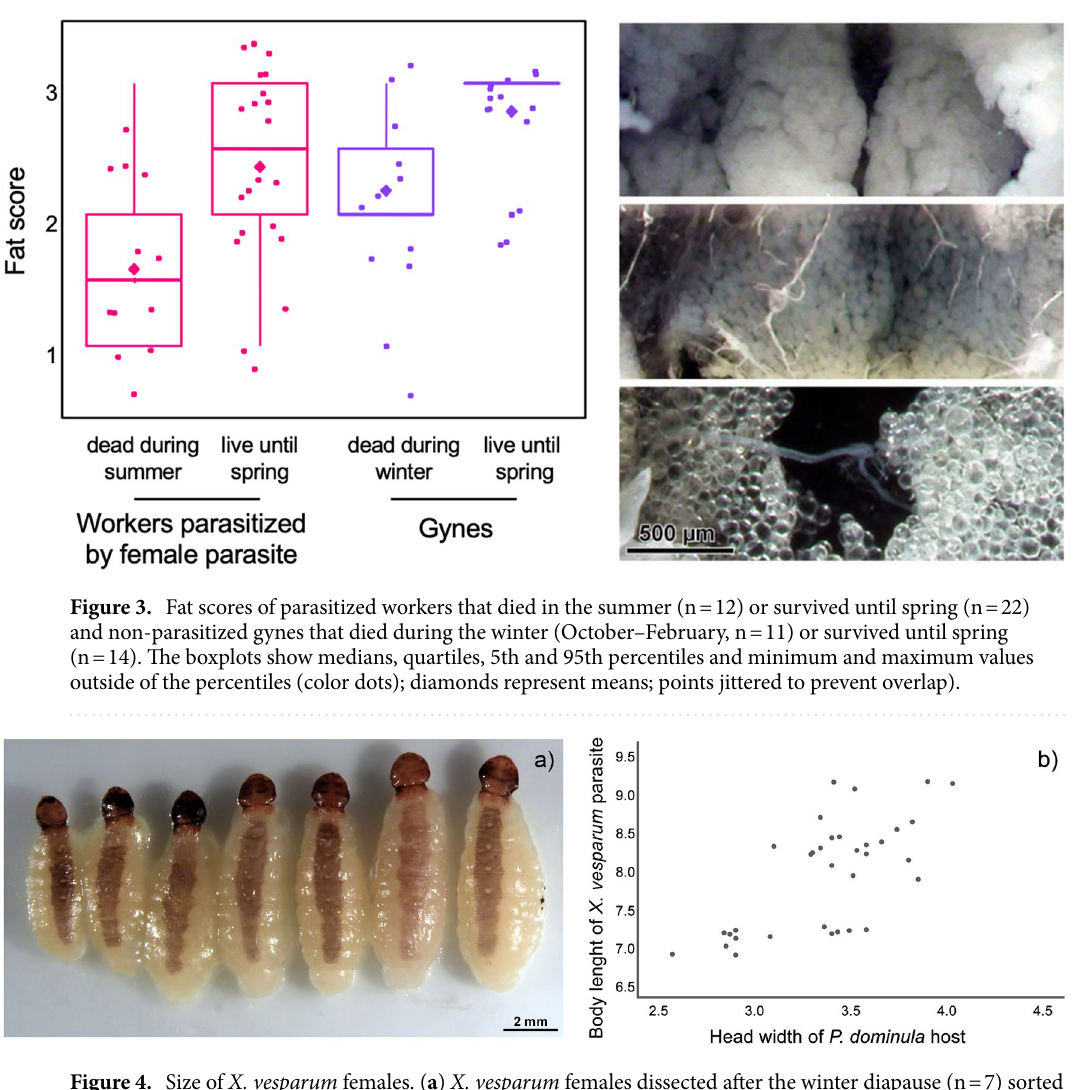
Size matching between the host and the parasite. There was a strong body size dimorphism between X. vespa- rum males and females: females were about twice as big as males (Supplementary Materials, Fig. S1). Length (7.93 ± 0.12 mm) and width (2.48 ± 0.05) of X. vesparum females were measured for the whole sample (n = 34) while male puparia were measured for a smaller sample of workers that died between October and January (length 4.9 ± 0.03, width 1.66 ± 0.03, n = 7), as only in this sample males did not extrude from the puparium (in all other cases, the puparium was opened and destroyed at male’s emergence). Parasite length, ranging between 6.88 and 9.15 mm, and parasite width, ranging between 1.84 and 3.35 mm, were not correlated (Pearson’s r = 0.23, n = 34, p = 0.195). Female parasites were highly variable in body size (Fig. 4a). Intriguingly, parasite length, but not parasite width, was positively correlated with host body size (Fig. 4b) (Pearson’s correlation, length: r = 0.68, p < 0.001 df = 32; width: r = 0.054, p = 0.76, df = 32). The correlation between parasite length and host size remained sig- nificant if we considered only the sample of spring-live workers (r = 0.69, p < 0.001, df = 20) as well as the sample of summer-dead workers (r = 0.63, p < 0.03, df = 10), whereas parasite width was not correlated ( p = 0.41 and p = 0.86, respectively). Unexpectedly, workers harbouring a larger X. vesparum female survived longer than workers infected by smaller parasites.